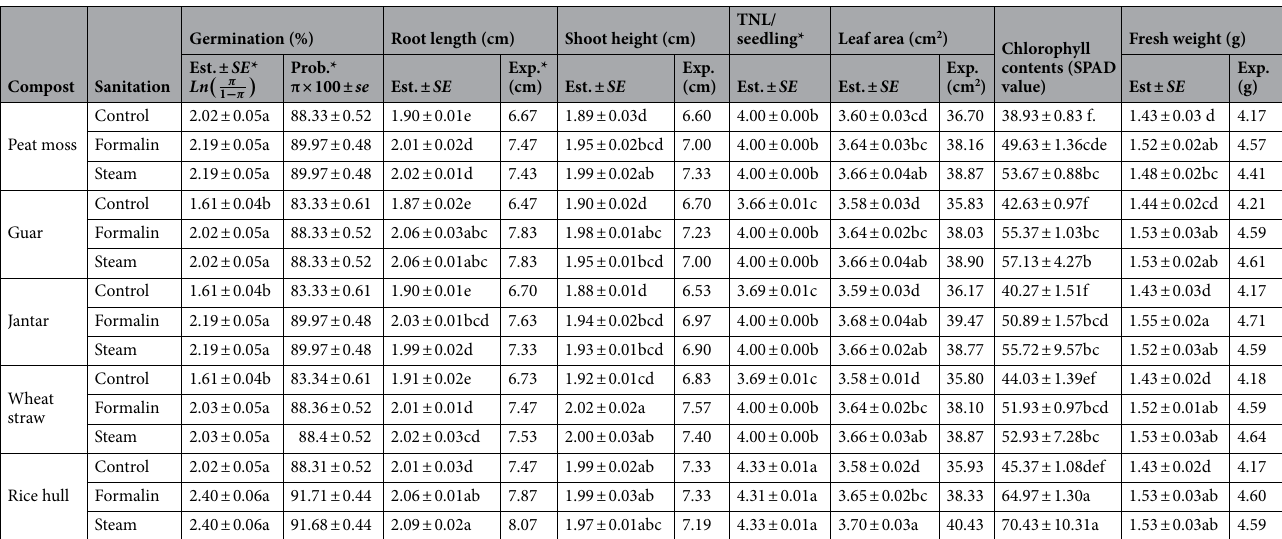
Table 1. Estimates of least square means ± standard errors calculated on account of natural log (on the scale of inference) with their exponential means (on the scale of measurement) for the determination of experimental variables and their probabilities of germination. Prob. probabilities, π probabilities of germination, SE standard error, Est. estimates, Exp. exponential, TNL total number of true leaves. Means sharing similar letter in a row or in a column are statistically non-significant ( p ≤